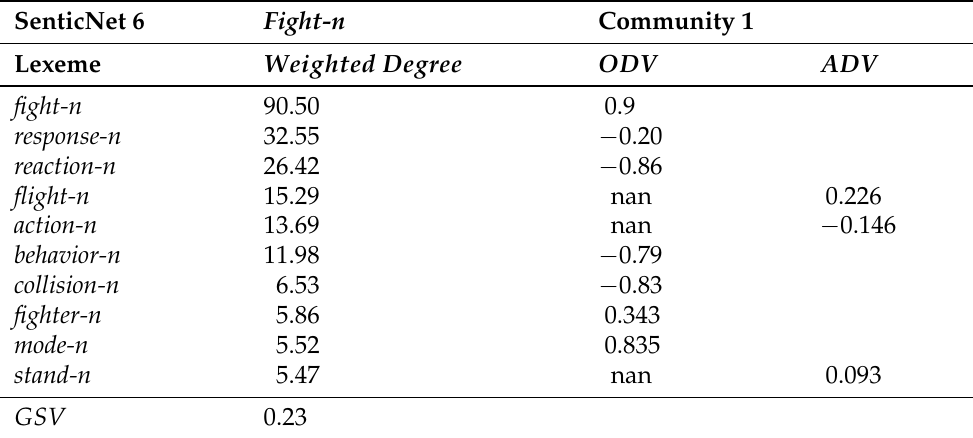
Table 7. Propagation of GSV of community 1 of lexical dependency graph of lexeme fight-n calculated with SenticNet 6 polarity_value on ententen13